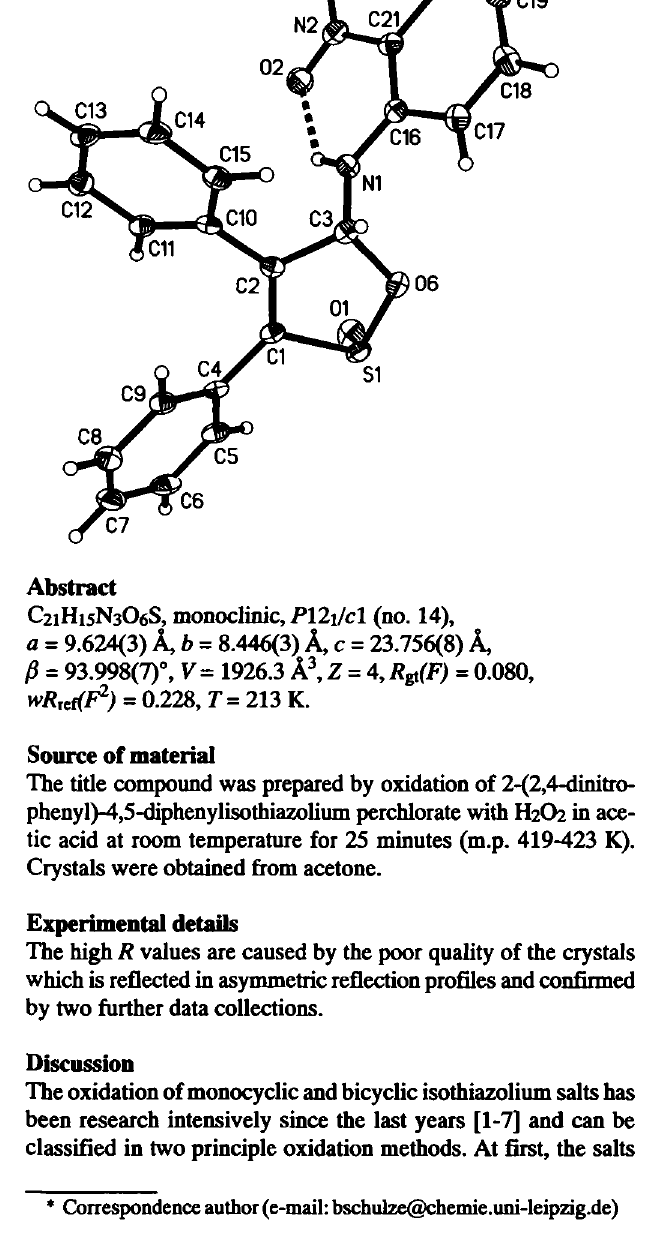
Table 2. Atomic coordinates and displacement parameters (in Ä 2